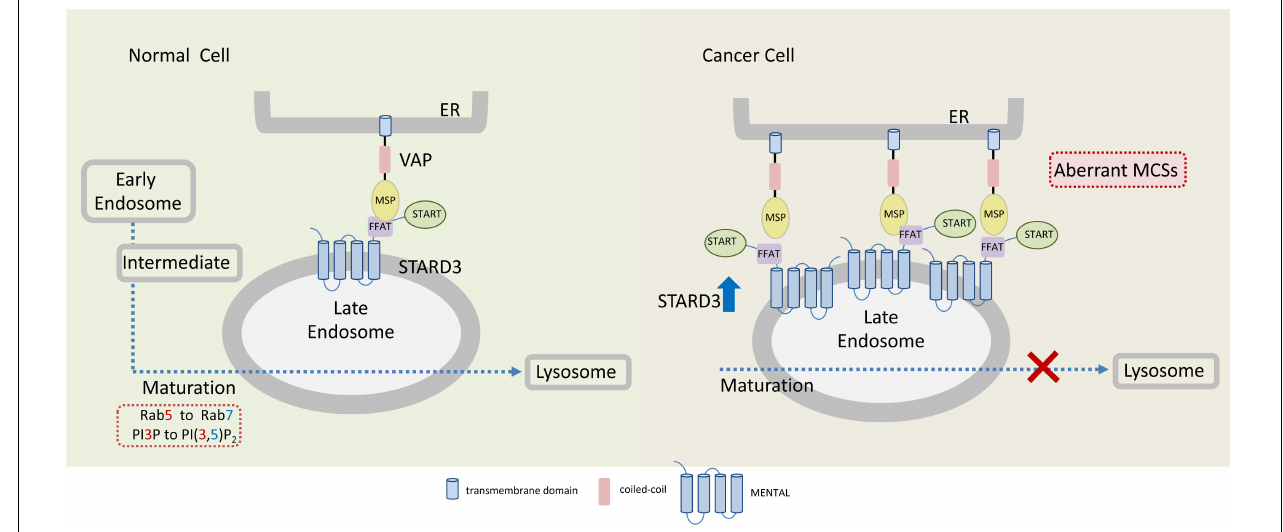
FIGURE 3 | Endoplasmic reticulum-endosome MCSs in normal and cancer cells overexpressing STARD3. The sterol-transfer protein STARD3 promotes the formation of MCSs between late endosomes (LE) and the endoplasmic reticulum (ER), where it mediates cholesterol transport. Tethering of ER and LE occurs through the interaction of the LE-membrane anchored STARD3 (via its FFAT-like motif) with the integral ER proteins VAPs. In cancer cells, overexpression of STARD3 possibly induces the formation of aberrant LE-ER MCSs thereby inhibiting further endosomal maturation. Endosomal maturation is commonly associated with Rab5 to Rab7 switch and with PI3P to PI(3,5)P 2 . MSP, major sperm protein